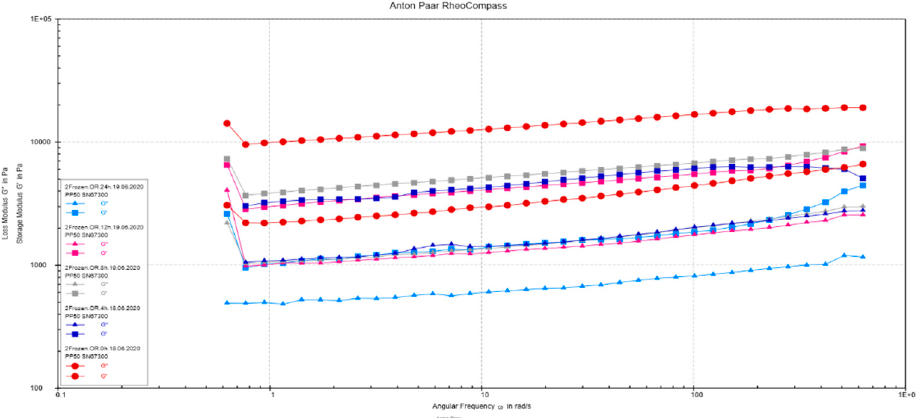
Figure 7. The storage (G’) and loss (G”) shear moduli for OR forzen sourdough at different fermentation times: 0, 4, 8, 12, and 24 h.